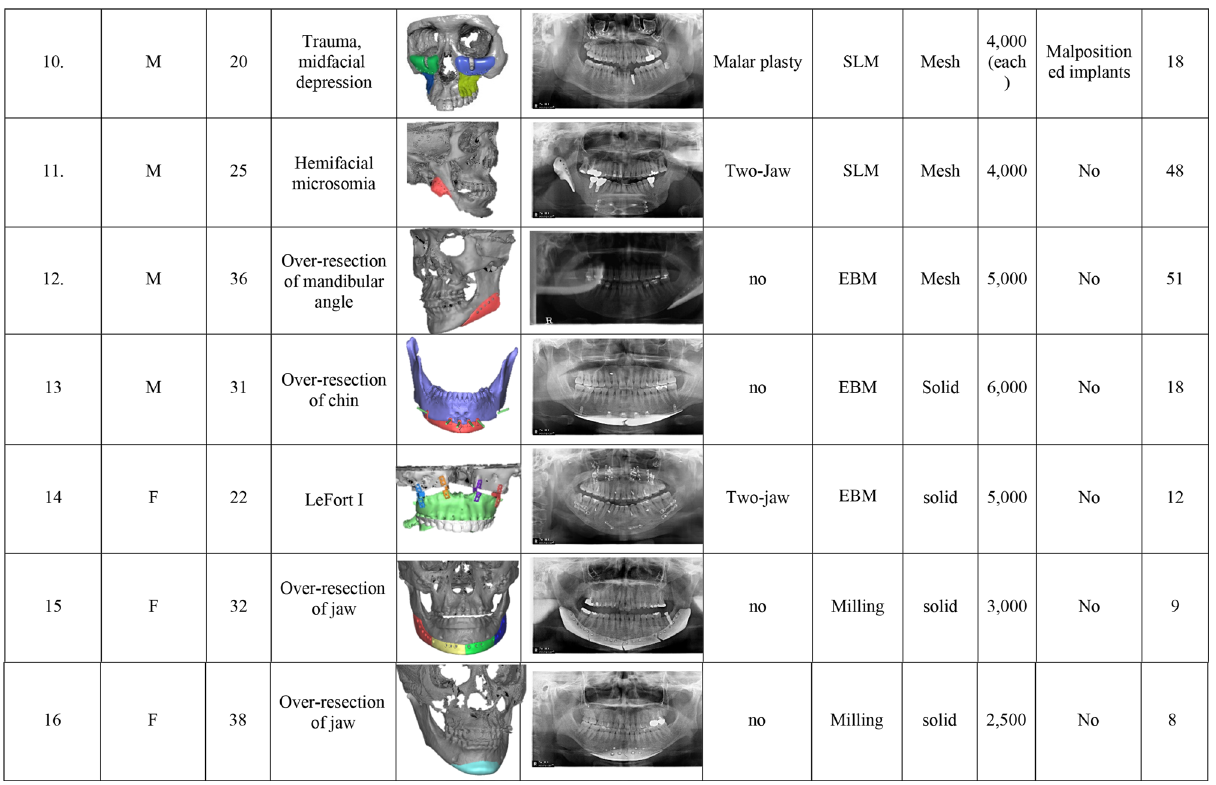
Table 2. General characteristics of participants. Abbreviations: Zyg zygoma, Recon reconstruction, AVM arteriovenous malformation, EBM electron beam melting, SLM selective laser